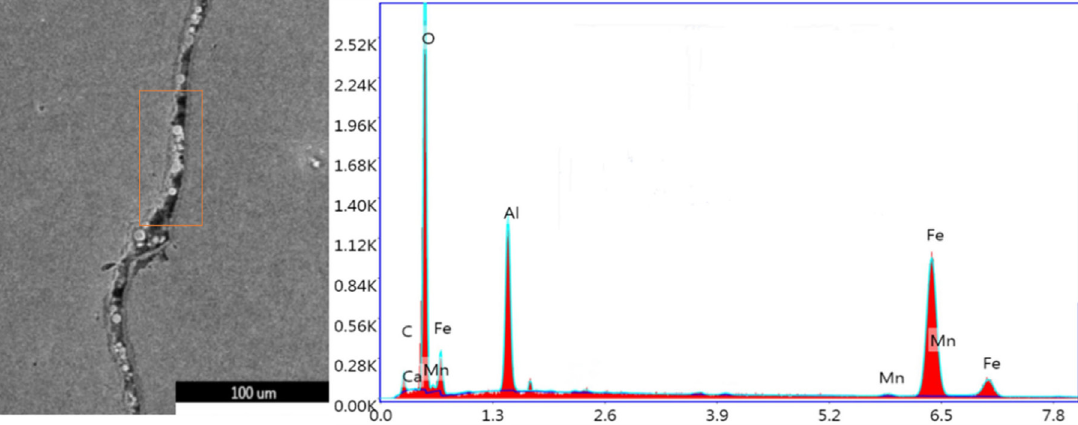
Figure 12. Scanning electron microscopy-energy disperse spectroscopy of